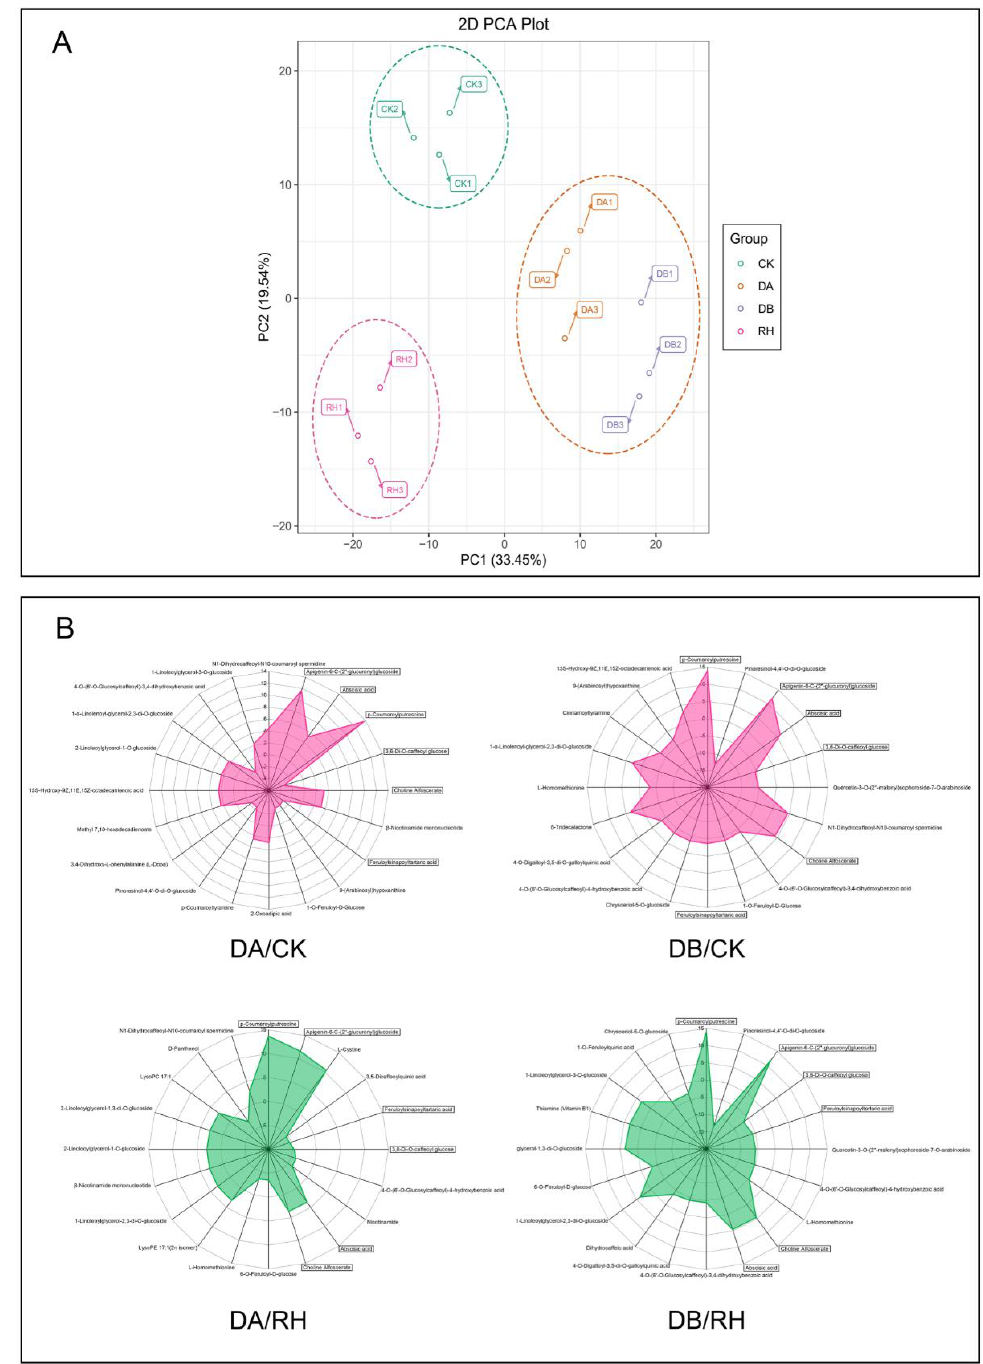
Figure 4. Multivariate statistical analyses of the differences in metabolites in ‘Qiuhong’ leaves among the control (CK), 15-day drought treatment (DA), 30-day drought treatment (DB), and rehydrated (RH) groups. The metabolite analysis in ‘Qiuhong’ under different treatments. ( A ) Principal component analysis (PCA) of metabolic profiles. ( B ) Radar charts showing the top 20 metabolites that contribute to separate samples between normal conditions (CK and RH) and drought treatments (DA and DB). The compounds surrounded by rectangles indicate the compounds that were common to all four charts. Data were plotted by Origin 2021.